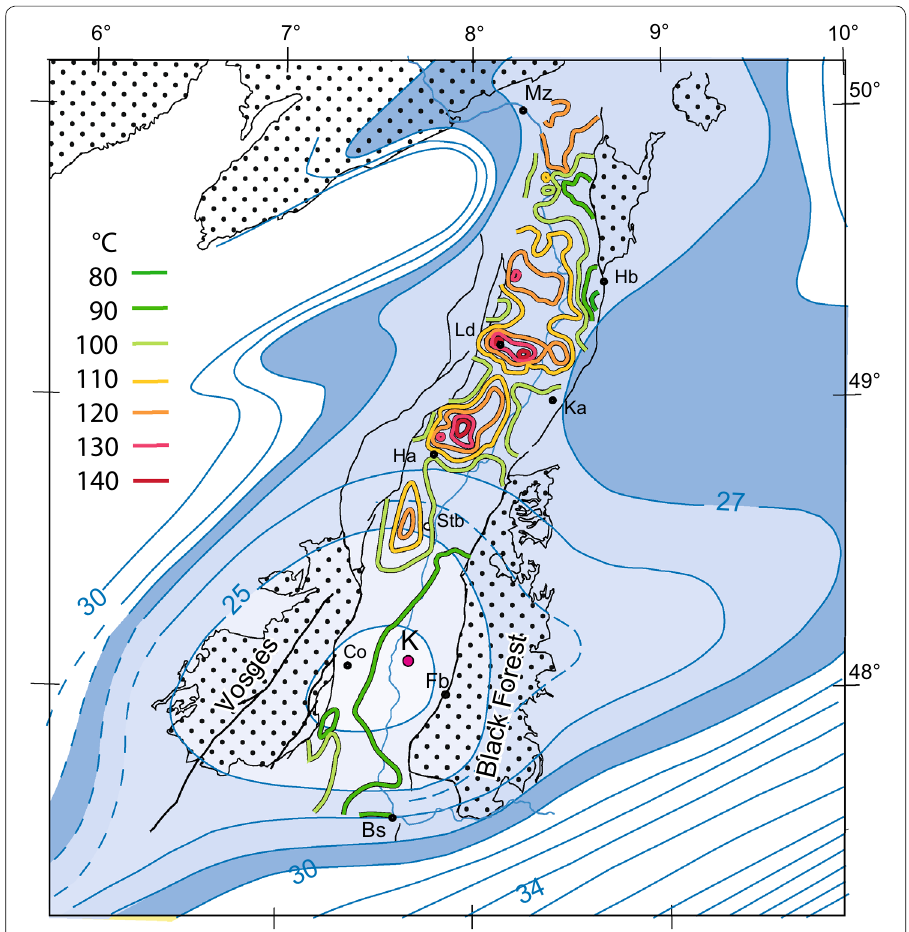
Fig. 2 Temperature distribution at 2000 m TVD, interpolated from borehole measurements of the Upper Rhinegraben (Baillieux et al. 2013) and topography (in km) of the Moho derived from refraction and reflexion seismic sections (e.g., Edel et al. 2006). K is the 17 Ma Kaiserstuhl